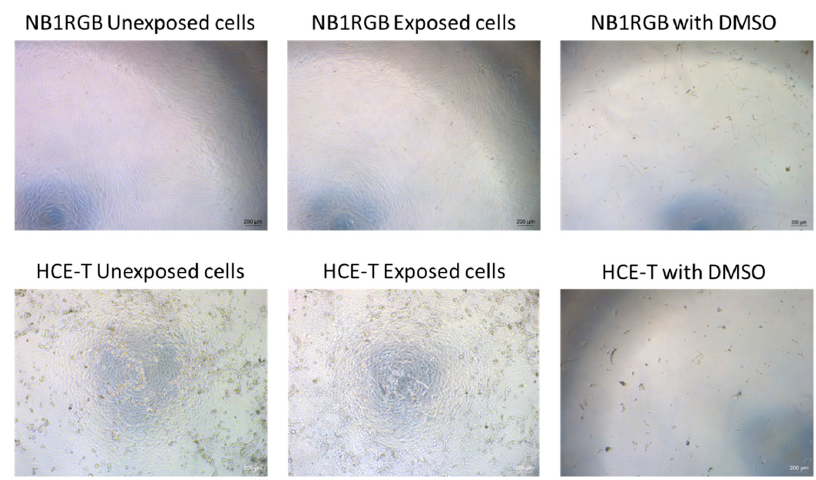
Figure 5. Cells following exposure to 0.3 – 0.6 THz waves for 94 h